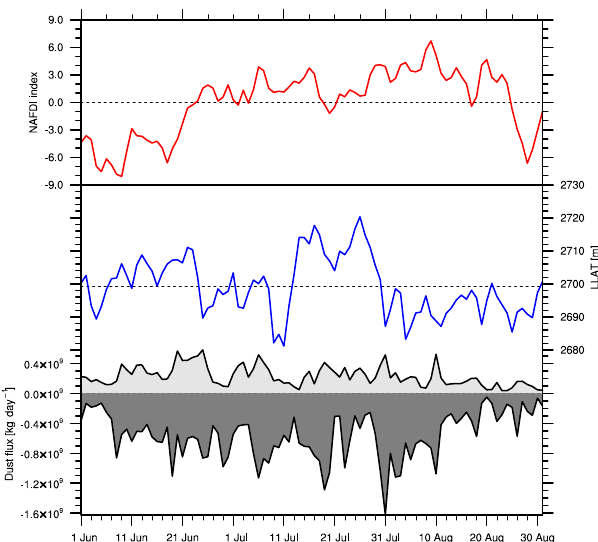
Figure 13. Time series of the NAFDI index (red) indicating the strength of the harmattan, the LLAT (blue) representing the depth of the SHL, and the westward (dark grey) and eastward (light grey) dust flux at 20 ◦ W integrated over the total column (0–22km alti- tude) and the latitudinal band between 10 and 25 ◦